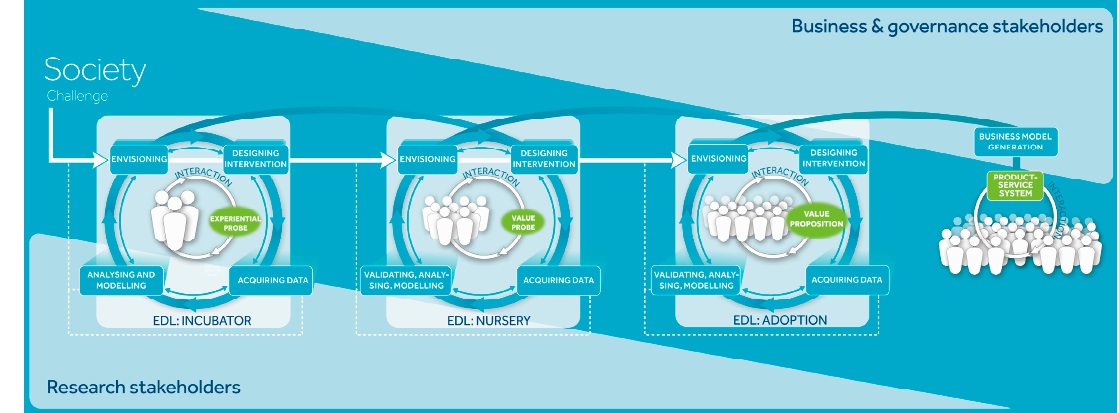
Figure 3. A schematic overview of the EDL method, showing the cyclic nature of the method and the progress from explorations towards value propositions.